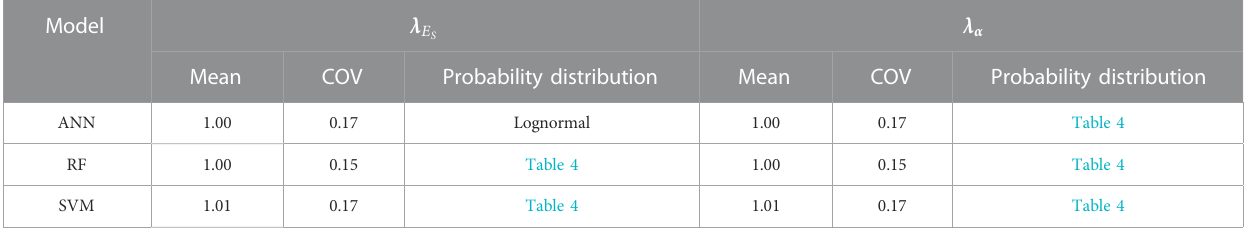
TABLE 2 Summary of the mean, COV, and probability distributions of the model biases for the ANN, RF, and SVM models. Model λ E